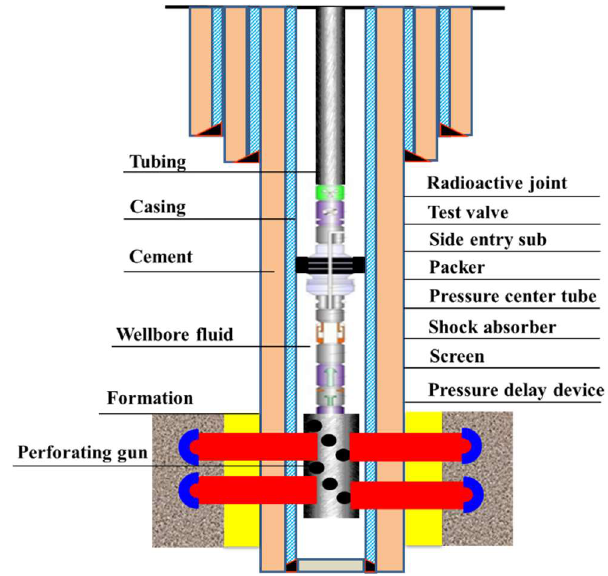
Figure 2. Structure of downhole tubing-conveyed perforation.